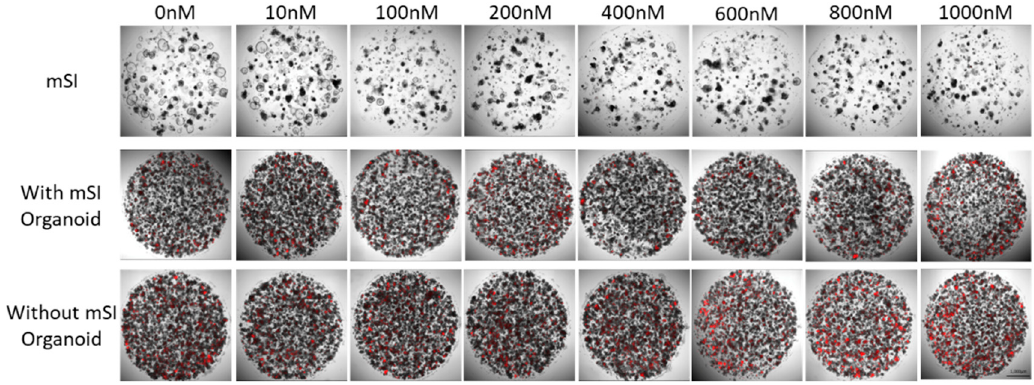
Figure 5. Dead cells labeled using PI (red) in mSI organoid and HT-29 spheroid after anti-drug treatment for 72 h.